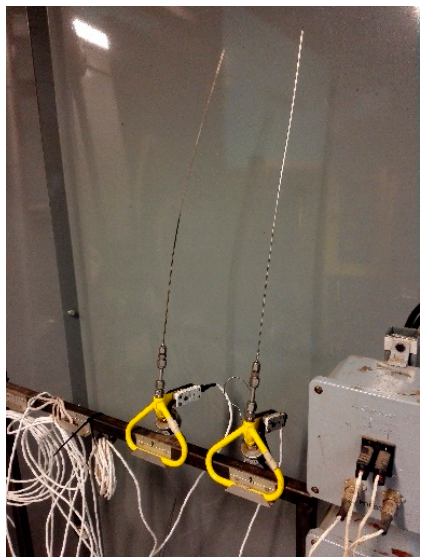
Figure 2. Probes used for mat temperature measurements.